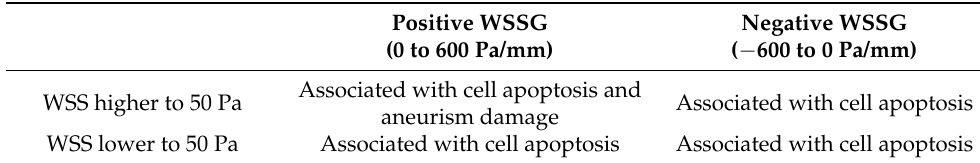
Table 3. Outcome of the combination of WSSG and WSS over endothelial lining based on a rabbit animal model of a bilateral common carotid ligation, and in vitro and CFD approaches